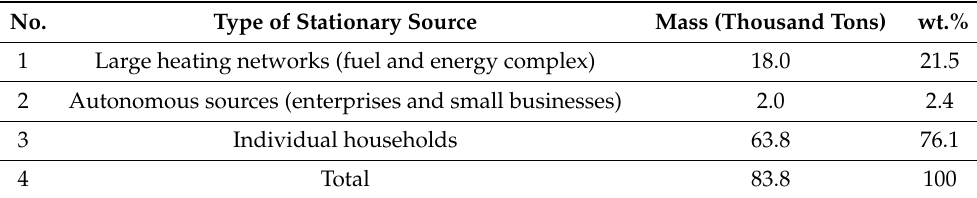
Table 3. Air emissions of pollutants from stationary sources in Ulan-Ude during the heating season of 2020/2021 (thousand